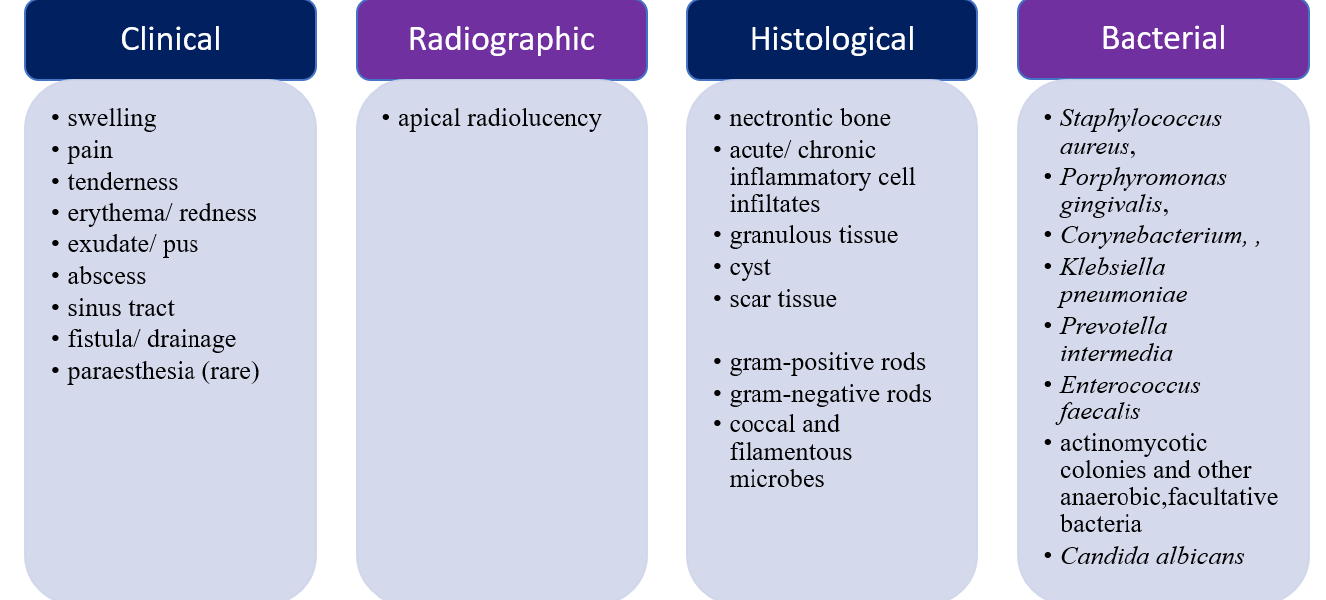
Figure 2. Different examination findings of implant periapical lesion.